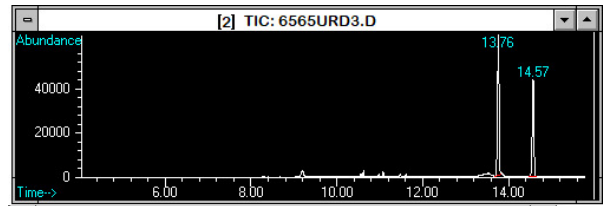
Figure 1. GC chromatogram for Morphine-TMS (13.76) and 6-MAM-TMS (14.57) from a urine